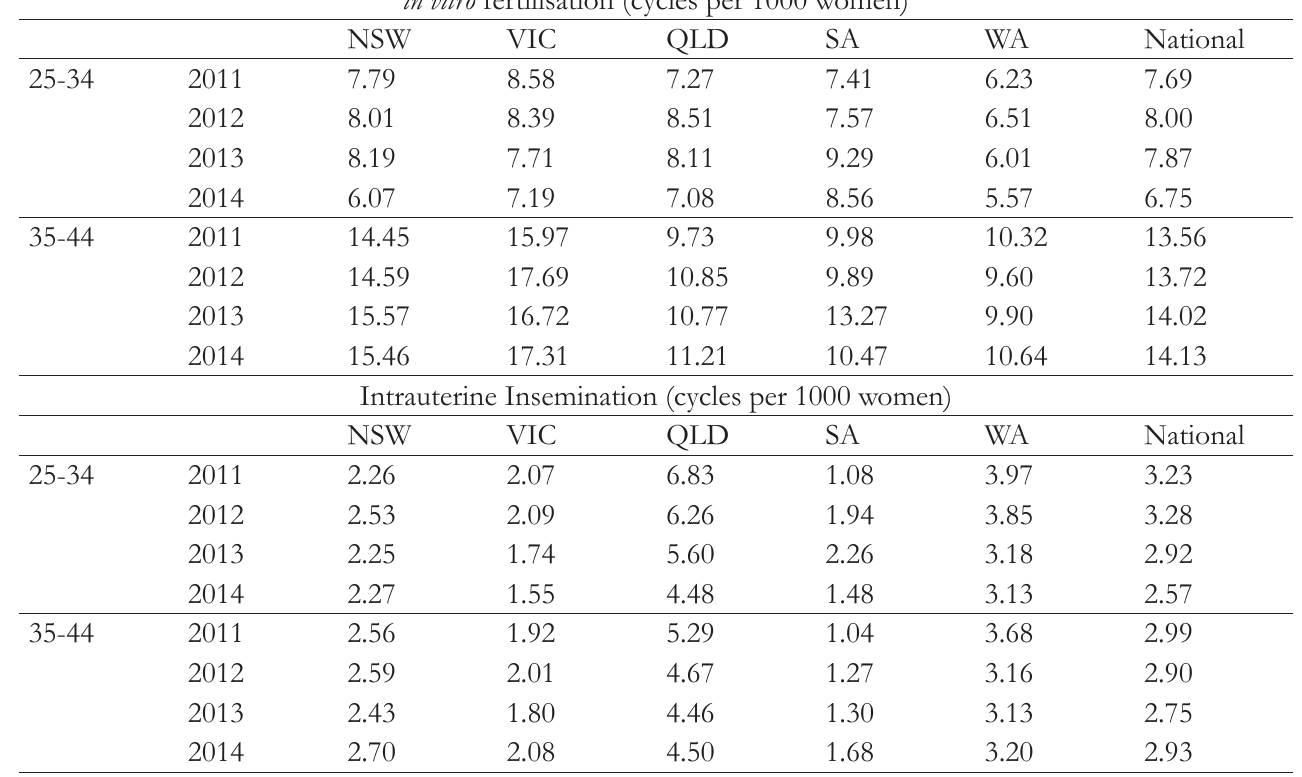
Table 1. Age-stratified incidence rates of in vitro fertilisation cycles proceeding to oocyte retrieval and intrauterine insemination cycles (cycles per 1000 women per year) from 2011 to 2014 for women in two age groups: 25 to 34 years and 35 to 44 years